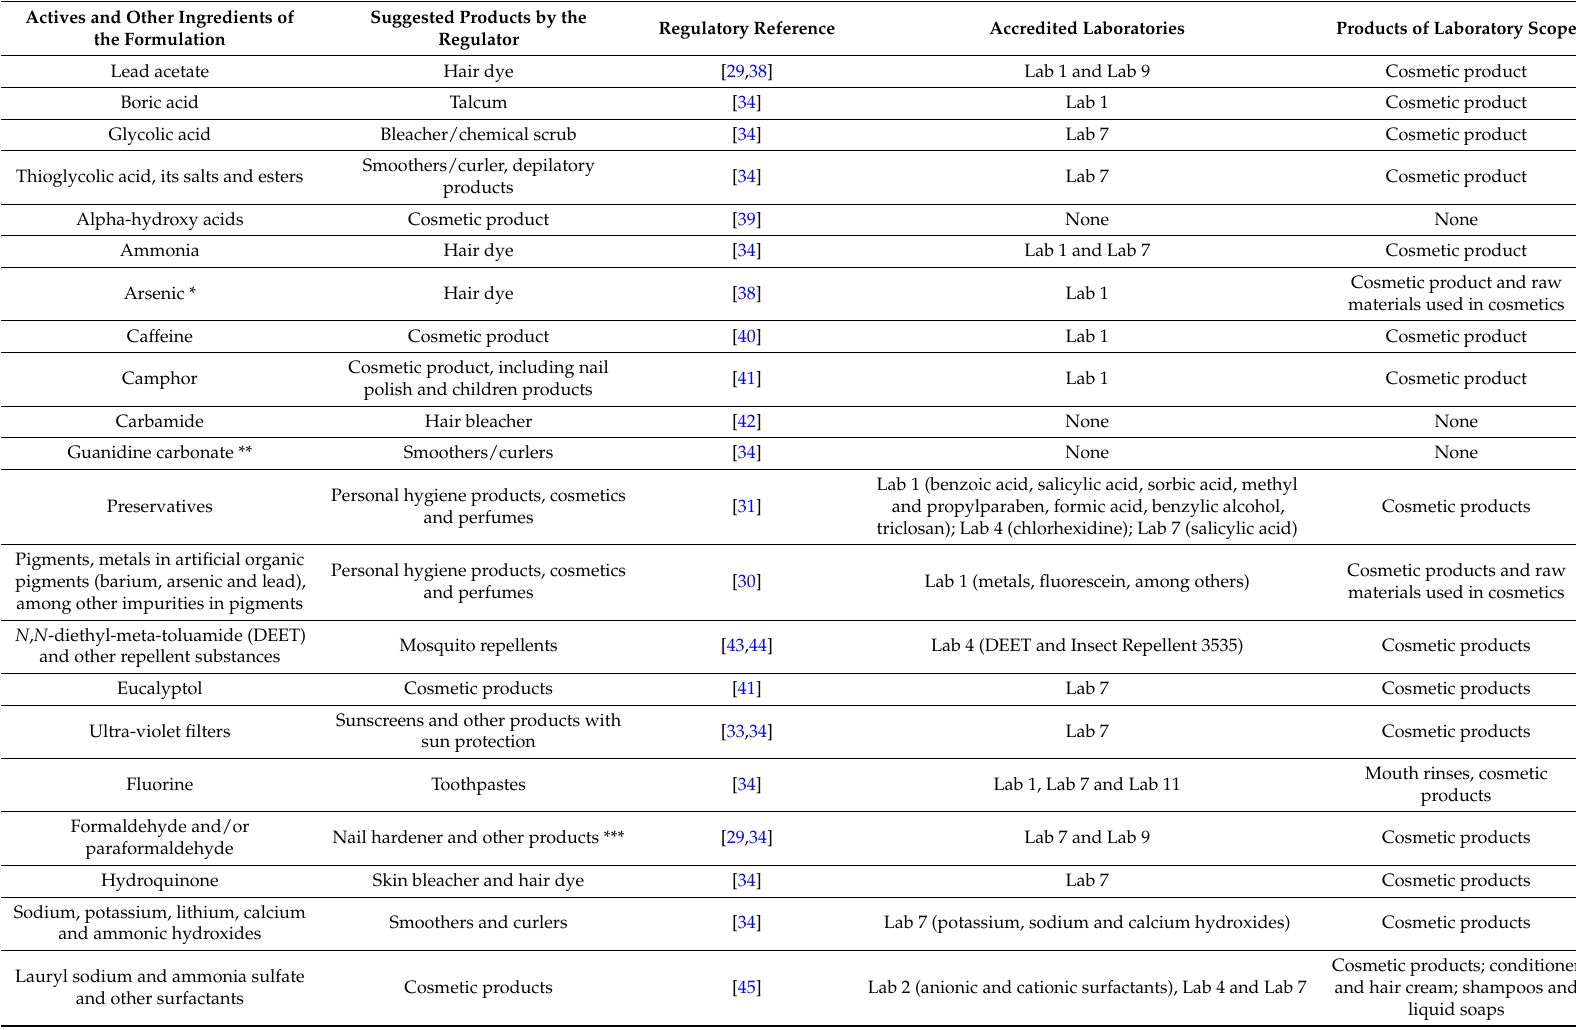
Table 5. Accredited laboratories for the determination of actives and other control components used in